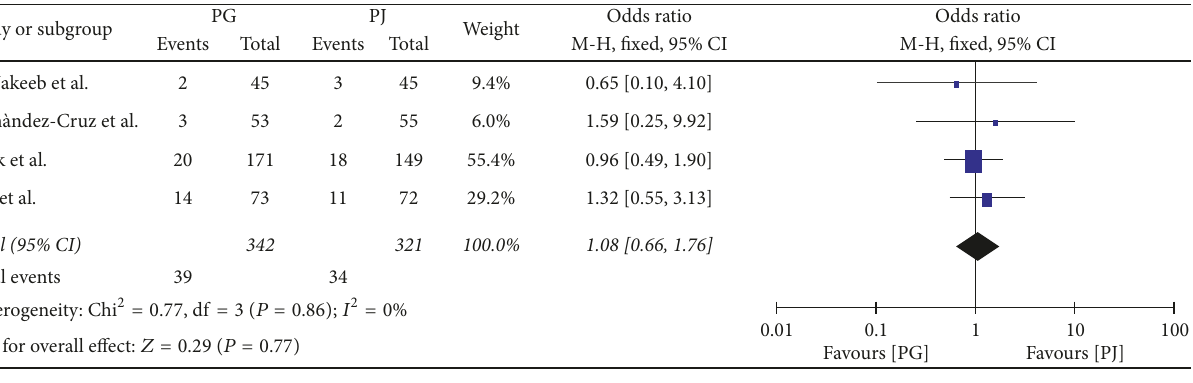
Figure 7: (a) Morbidity, (b) mortality, (c) reoperation, and (d) wound